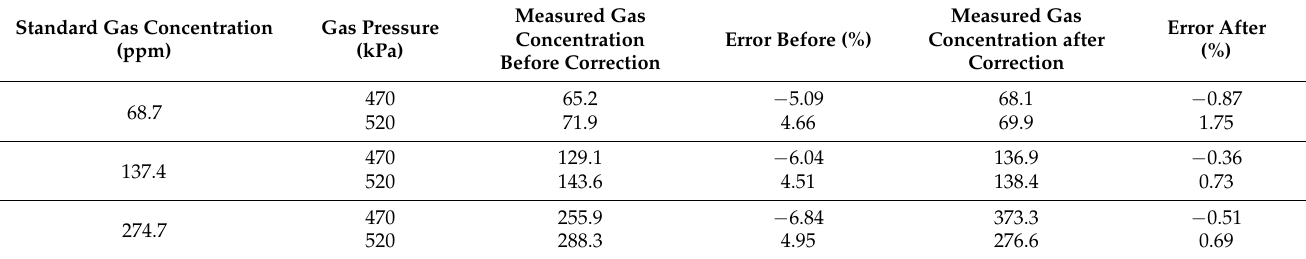
Table 4. Effect of pressure fluctuation correction model.